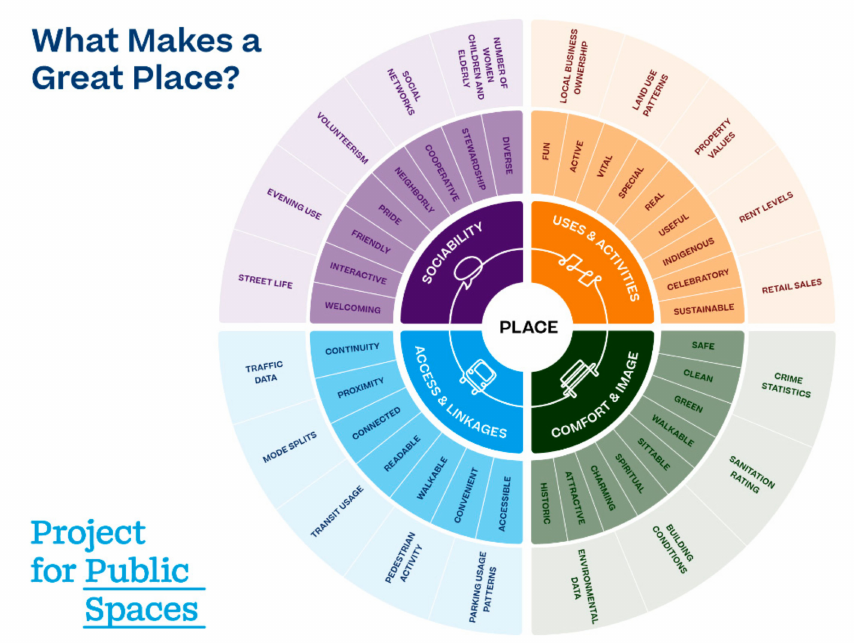
Figure 8. The place diagram (Source: Project for Public